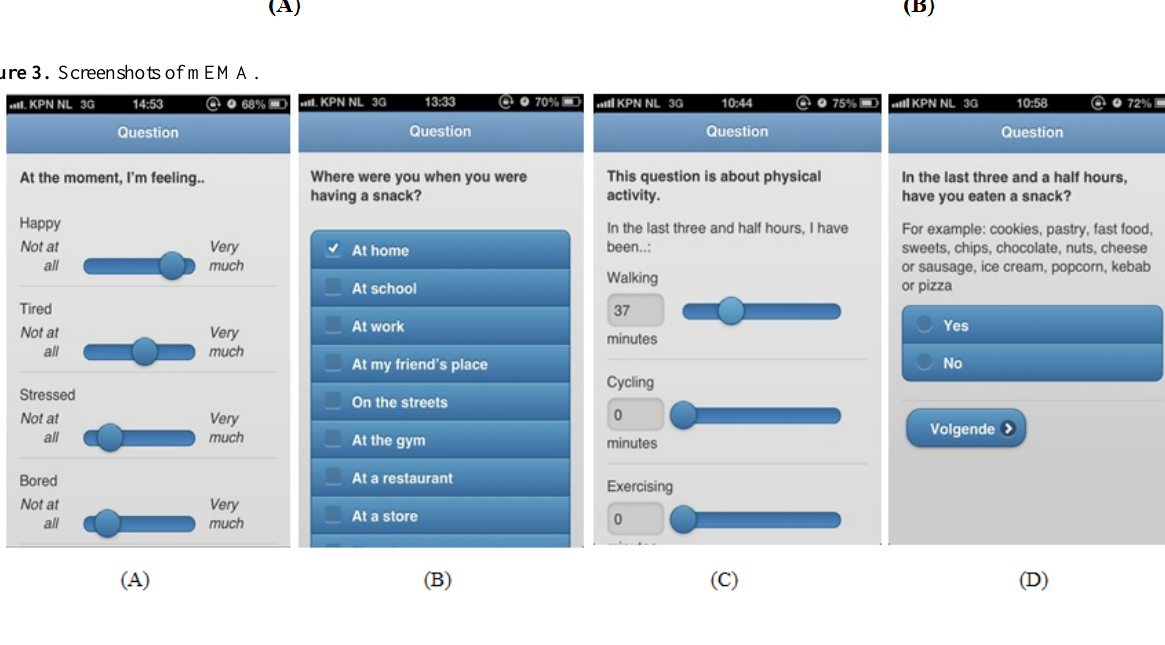
Figure 3. Screenshots of